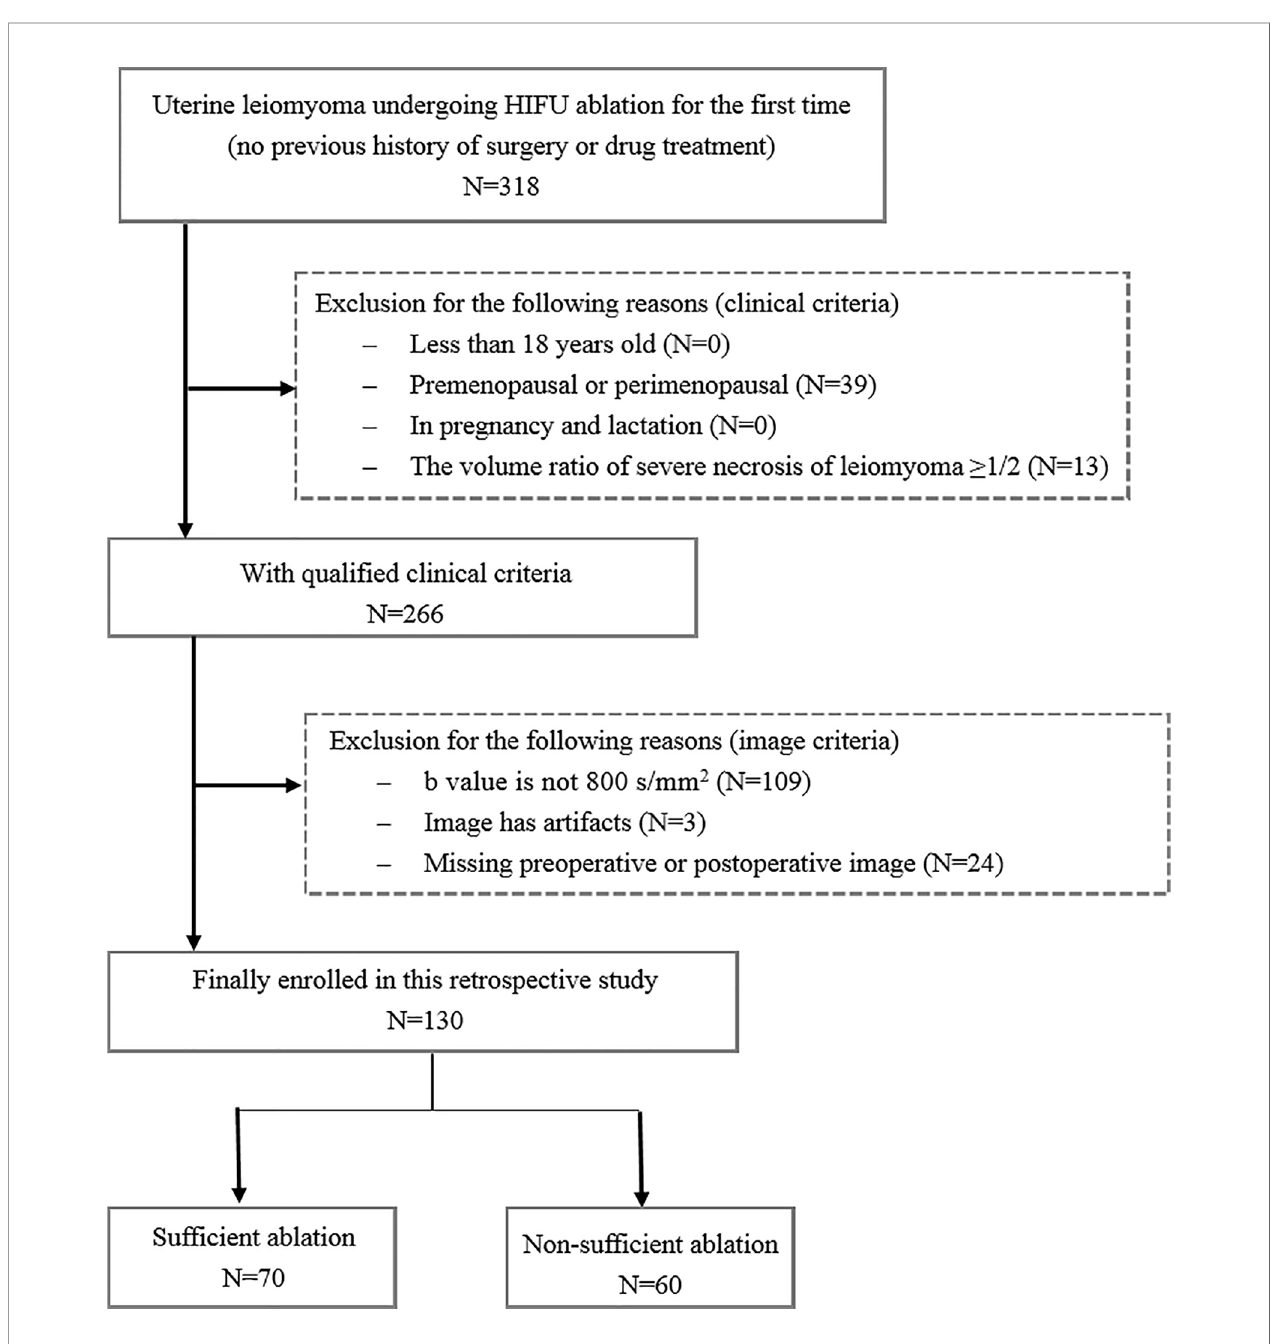
FIGURE 2 | Patient recruitment